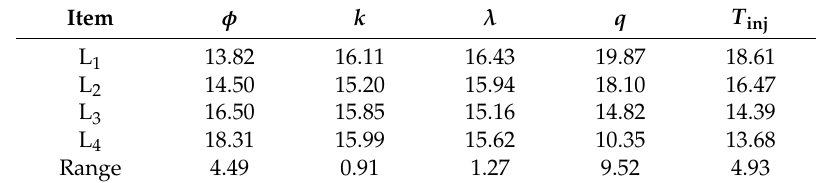
Table 6. Mean effects of different levels of conditions on the electric power at t = 20 years.